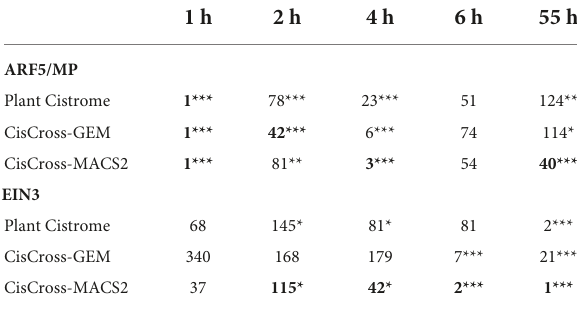
The ranks for two TF regulators ARF5, and EIN3 are shown. The asterisk marks the significance of enrichment corrected with Benjamini-Hochberg (FDR), ***